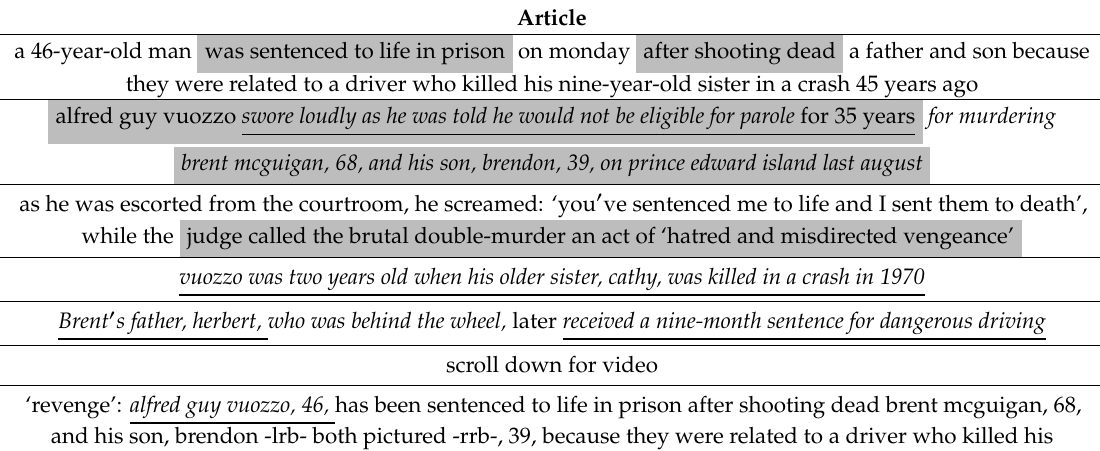
Table 2. A sample news article in the test